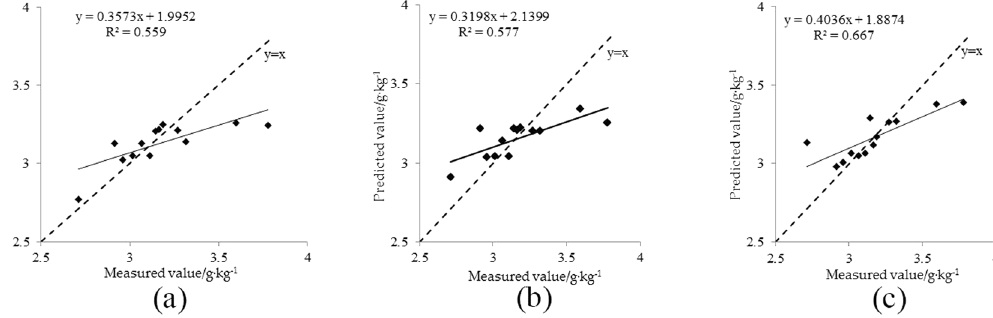
Figure 6. Scatter plots of the measured and predicted values of validation with SVMR 1( a ), 2( b ) and 3( c ) based on vegetation